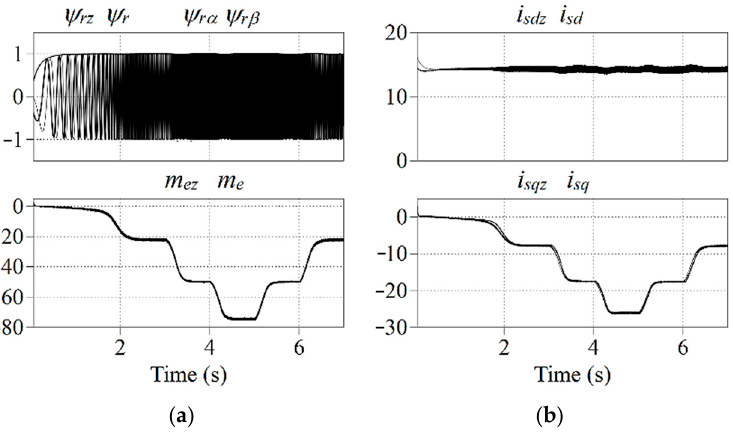
Figure 17. The waveforms of: ( a ) the set rotor flux ψ rz , the set driving torque of a wind turbine m ez and estimated values ψ r and electromagnetic torque of generator m e ; ( b ) the set current components in the d and q axes and their measured values.